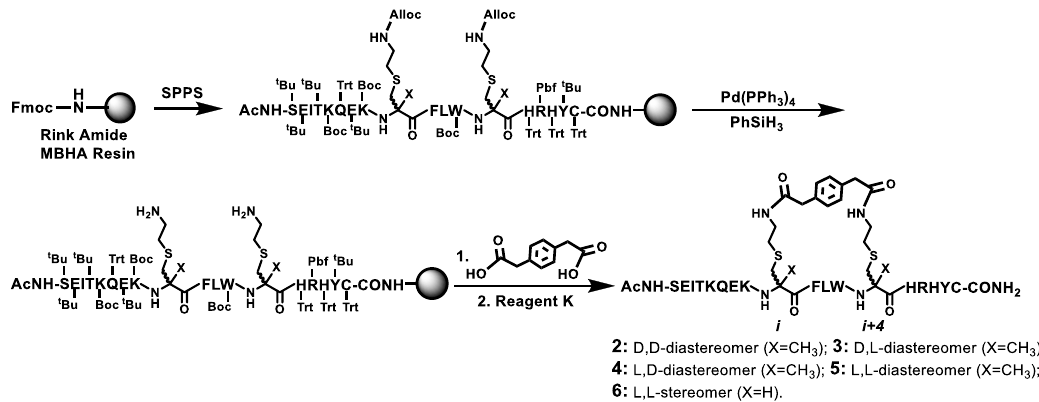
Scheme 2. The solid phase synthesis of the stapled peptides 2 – 6 on Rink amide MBHA resin. The